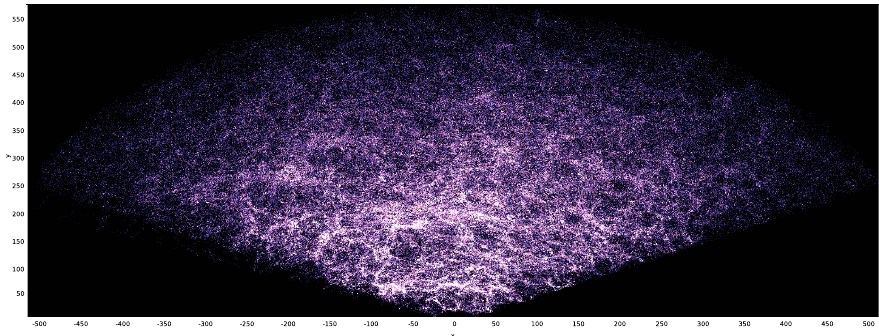
Fig. 1. Galaxy distribution in SDSS DR8 in cartesian coordinate system (where x is in the zenith direction). Standard transformation rules from spherical to cartesian coordinates were